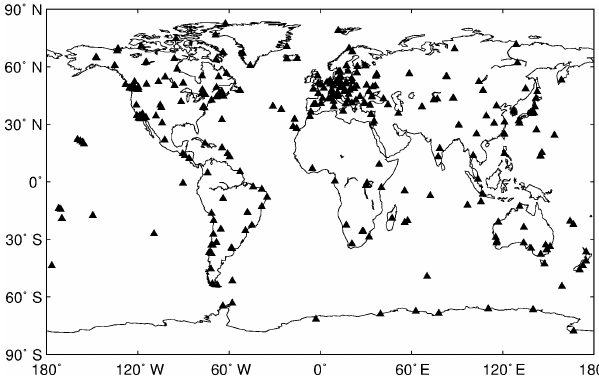
Figure 5. Distribution of global IGS sites involved in